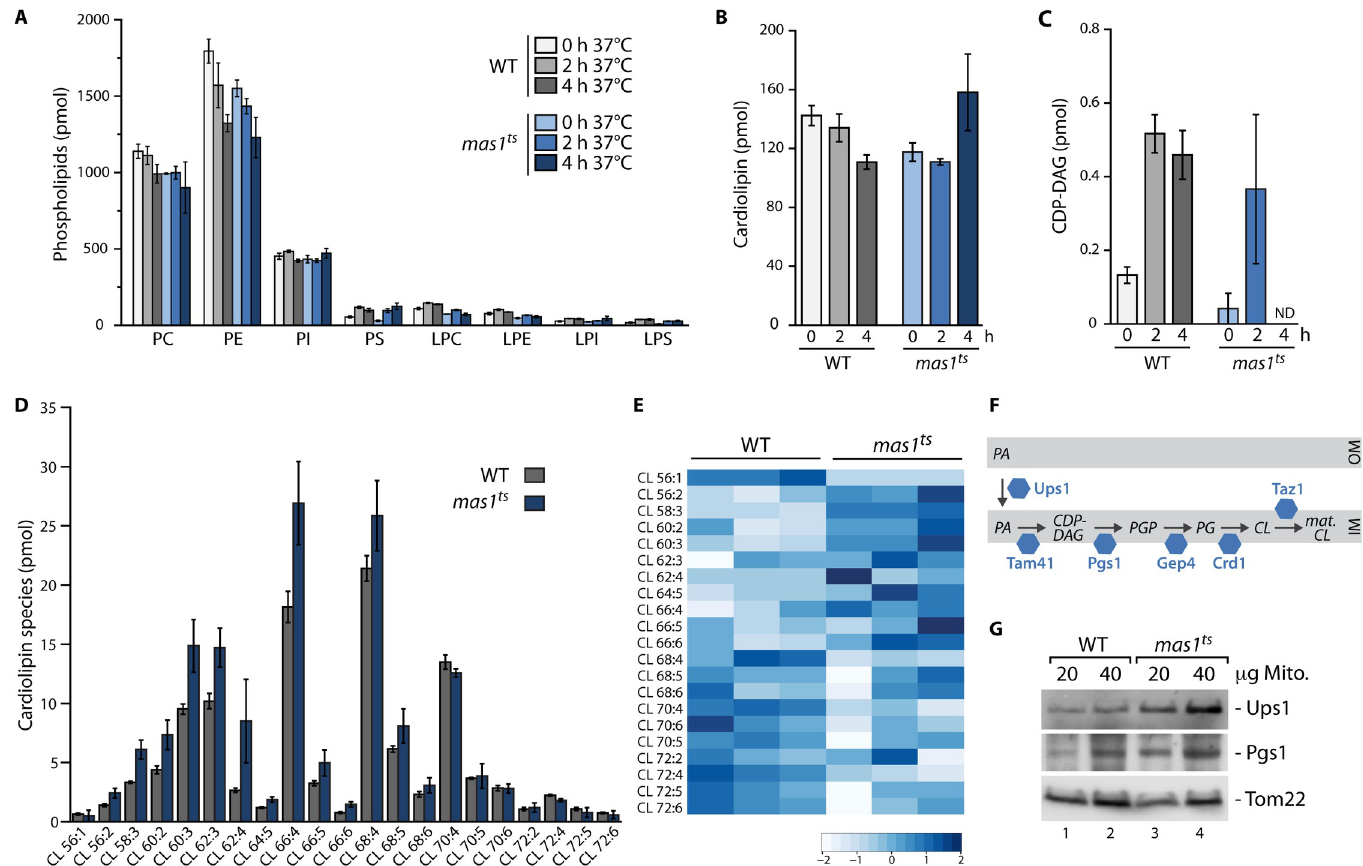
Fig 2. mtUPR induces dynamic remodelling of the mitochondrial signature lipid cardiolipin. (A) Lipidomic analysis of indicated phospholipids in highly purified wild-type (WT) and mas1 ts mitochondria isolated after growth at permissive temperature, or after induction of mtUPR for 2 and 4 hours. n = 3, data represent means ± SEM. PC, phosphatidylcholine; PE, phosphatidylethalonamine; PI, phosphatidylinositol; PS, phosphatidylserine; LPC, lysophosphatidylcholine; LPE, lysophosphatidylethalonamine; LPI, lysophosphatidylinositol; LPS, lysophosphatidylserine. (B) Quantification of cardiolipin in WT and mas1 ts mitochondria isolated after growth under non-stress conditions, or after mtUPR induction for 2 or 4 hours. Non-standardized, absolute values in pmol measured in total lipid extracts from isolated, highly purified mitochondria are shown. n = 3, data represent means ± SEM. (C) Quantification of the CL-precursor CDP-diacylglycerol (CDP-DAG) in WT and mas1 ts mitochondria isolated after growth at permissive temperature, or after induction of mtUPR for 2 and 4 hours. Non-standardized, absolute values in pmol measured in total lipid extracts from isolated, highly purified mitochondria are shown. n = 3, data represent means ± SEM. ND, not detected. (D) Quantification of indicated CL subspecies in WT and mas1 ts mitochondria isolated after induction of mtUPR for 4 hours. Non-standardized, absolute values in pmol measured in total lipid extracts from isolated, highly purified mitochondria are shown. n = 3, data represent means ± SEM. (E) Heatmap of distribution of different CL subspecies standardized to total CL content per sample in WT and mas1 ts mitochondria isolated from cells shifted for 4 hours to non-permissive growth temperature. Heatmaps were generated using standardized values in mol% and thus total CL content in each individual sample was set to 100% to represent relative CL species distribution within each sample. Relative changes, scaled and centered for each CL species, are depicted. Shown are three biological replicates for each strain. (F) Schematic overview of the CL biosynthesis pathway in mitochondria. Adapted from [41]. PGP, phosphatidylglycerolphosphate; PG, phosphatidylglycerol; OM, outer mitochondrial membrane; IM, inner mitochondrial membrane. (G) Immunoblot analysis of WT and mas1 ts mitochondria isolated from cells shifted to non-permissive temperature for 10 hours. Tom22 serves as loading